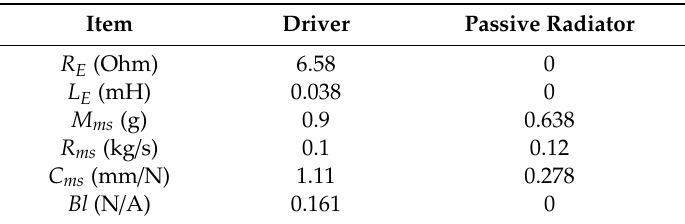
Figure 6. Equivalent circuit of speaker enclosure with passive radiator. Table 1. Parameter identification.